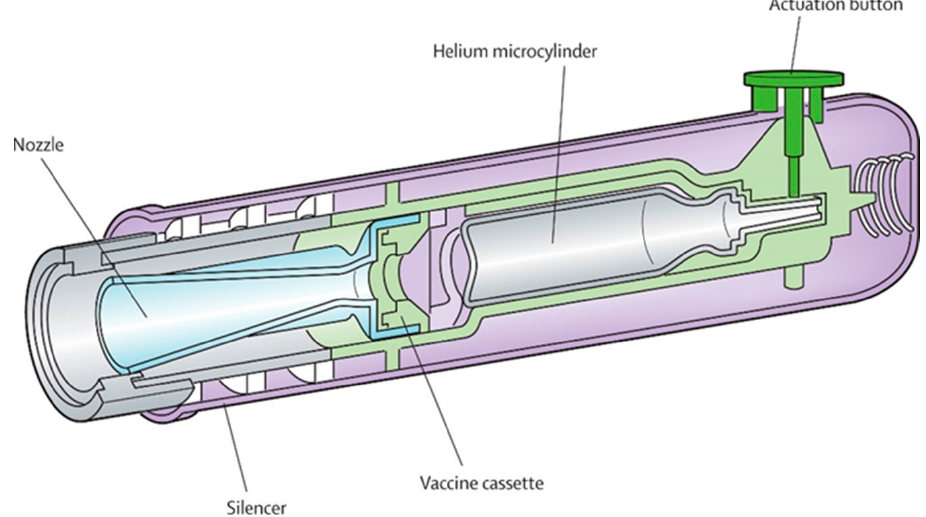
Figure 8. PowderJect ND5.2, a prototype single-use delivery device for epidermal powder immunisation [121].